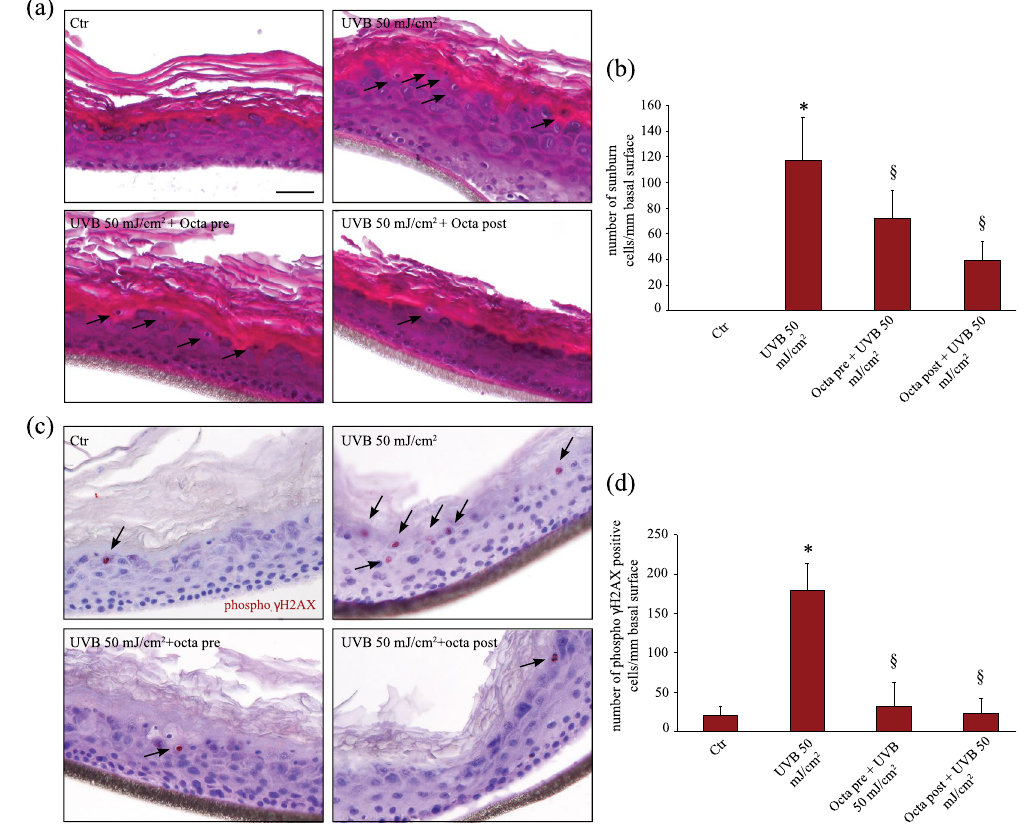
Figure 6. Photoprotective effect of Octa in epidermal equivalents. ( a ) Haematoxylin-eosin staining of skin samples exposed to UVB 50 mJ/cm2 and pre or post-treated with 90 µ M Octa. Arrows point sunburn cells. Nuclei are counterstained with haematoxylin. Scale bar: 50 µ m. ( b ) Quantitative analysis of the number of sunburn cells expressed as mean value ± SD per mm of basal surface. * p < 0,01 (vs non-irradiated cells), § p < 0,01 (vs UVB-irradiated cells) ( c ) Immunohistochemical analysis of phospho- γ H2AX positive cells (arrows) of skin samples exposed to UVB 50 mJ/cm2 and pre or post-treated with 90 µ M Octa. Nuclei are counterstained with haematoxylin. Scale bar: 50 µ m. ( d ) Corresponding quantitative analysis of the signal evaluated by counting the number of positive cells/total cells. * p < 0,01 (vs non-irradiated cells), § p < 0,01 (vs UVB-irradiated